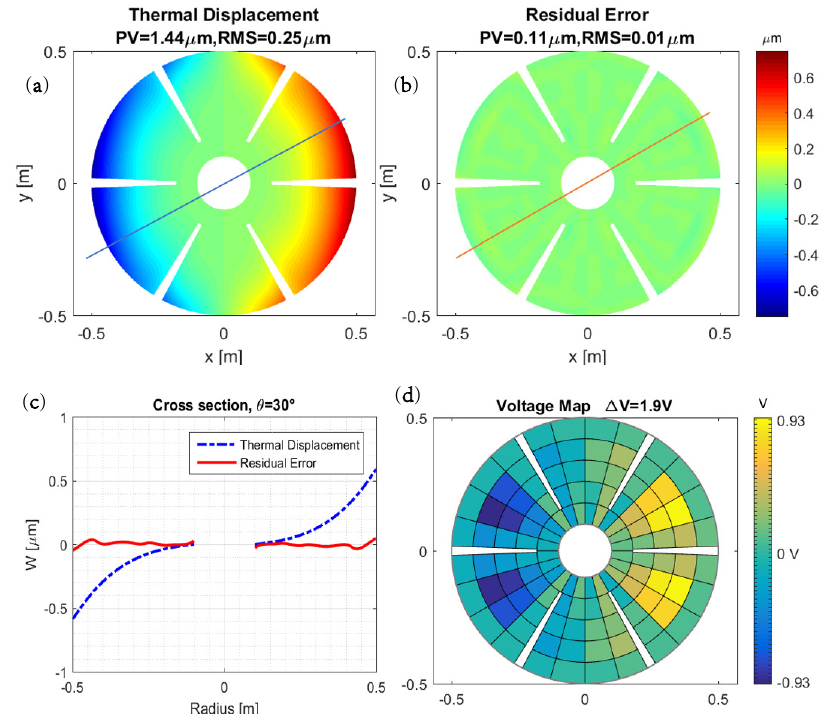
Figure 10. Effect of a thermal gradient of ∓ 15 ◦ K on the petal reflector with balanced layer design and near zero CTE substrate. ( a ) Thermal displacements along z without control. ( b ) Residual displacements after control. ( c ) Cross section at 30 ◦ of the displacements before (blue) and after control (red). ( d ) Map of the correcting